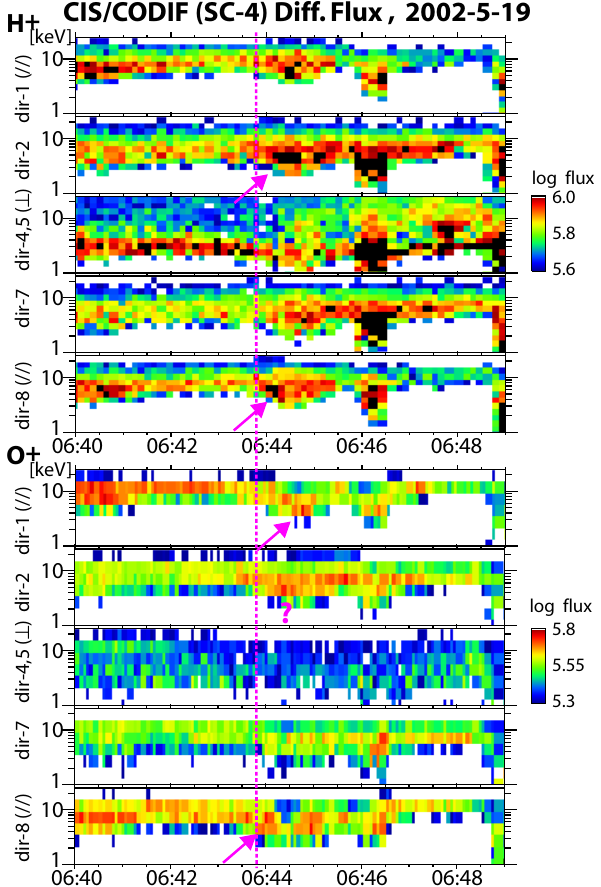
Fig. 8. Energy-time spectrogram of differential particle flux (cm − 2 s − 1 str − 1 keV − 1 ) of 1 ∼ 25keV H + (upper 5 panels) and O + (lower 5 panels) observed by CIS/CODIF from SC-4 during 06:40 ∼ 06:49UT on 19 May 2002. For both H + and O + , five di- rections are shown: nearly anti-field-aligned from north to south (sector 1), oblique (sector 2), nearly perpendicular to the mag- netic field (sectors 4 and 5), oblique (sector 7), and nearly field- aligned from south to north (sector 8), respectively. The O + count is not contamination from H + except 3keV peak at around 06:44:10 ∼ 06:44:40UT at direction 2 (question mark) according to time-of-flight spectrum (not shown here). The sudden intensifica- tions marked by arrows are real for both H + and O +